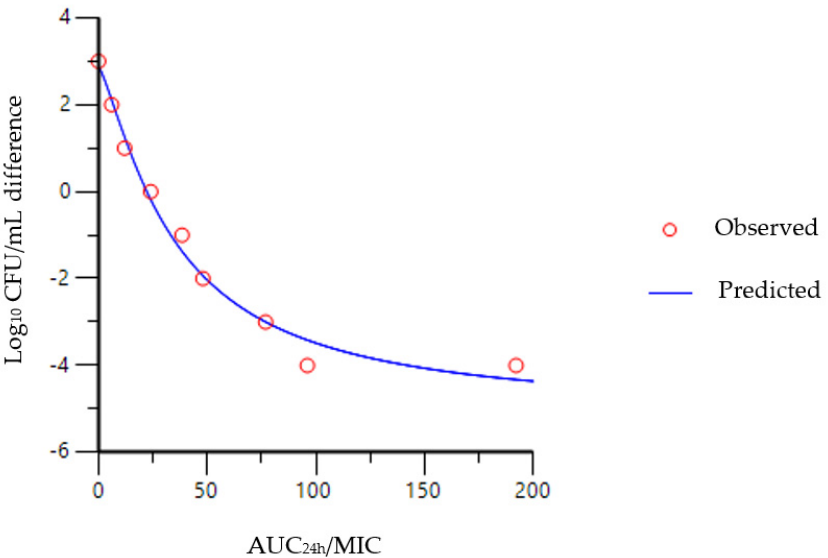
Figure 4. Sigmoidal Emax correlation between SS96 bacterial count (CFU/mL) and in vitro AUC 24h /MIC of florfenicol, illustrating the values required for bacteriostatic, bactericidal and eradi- cation effects in synovial fluid in pig.